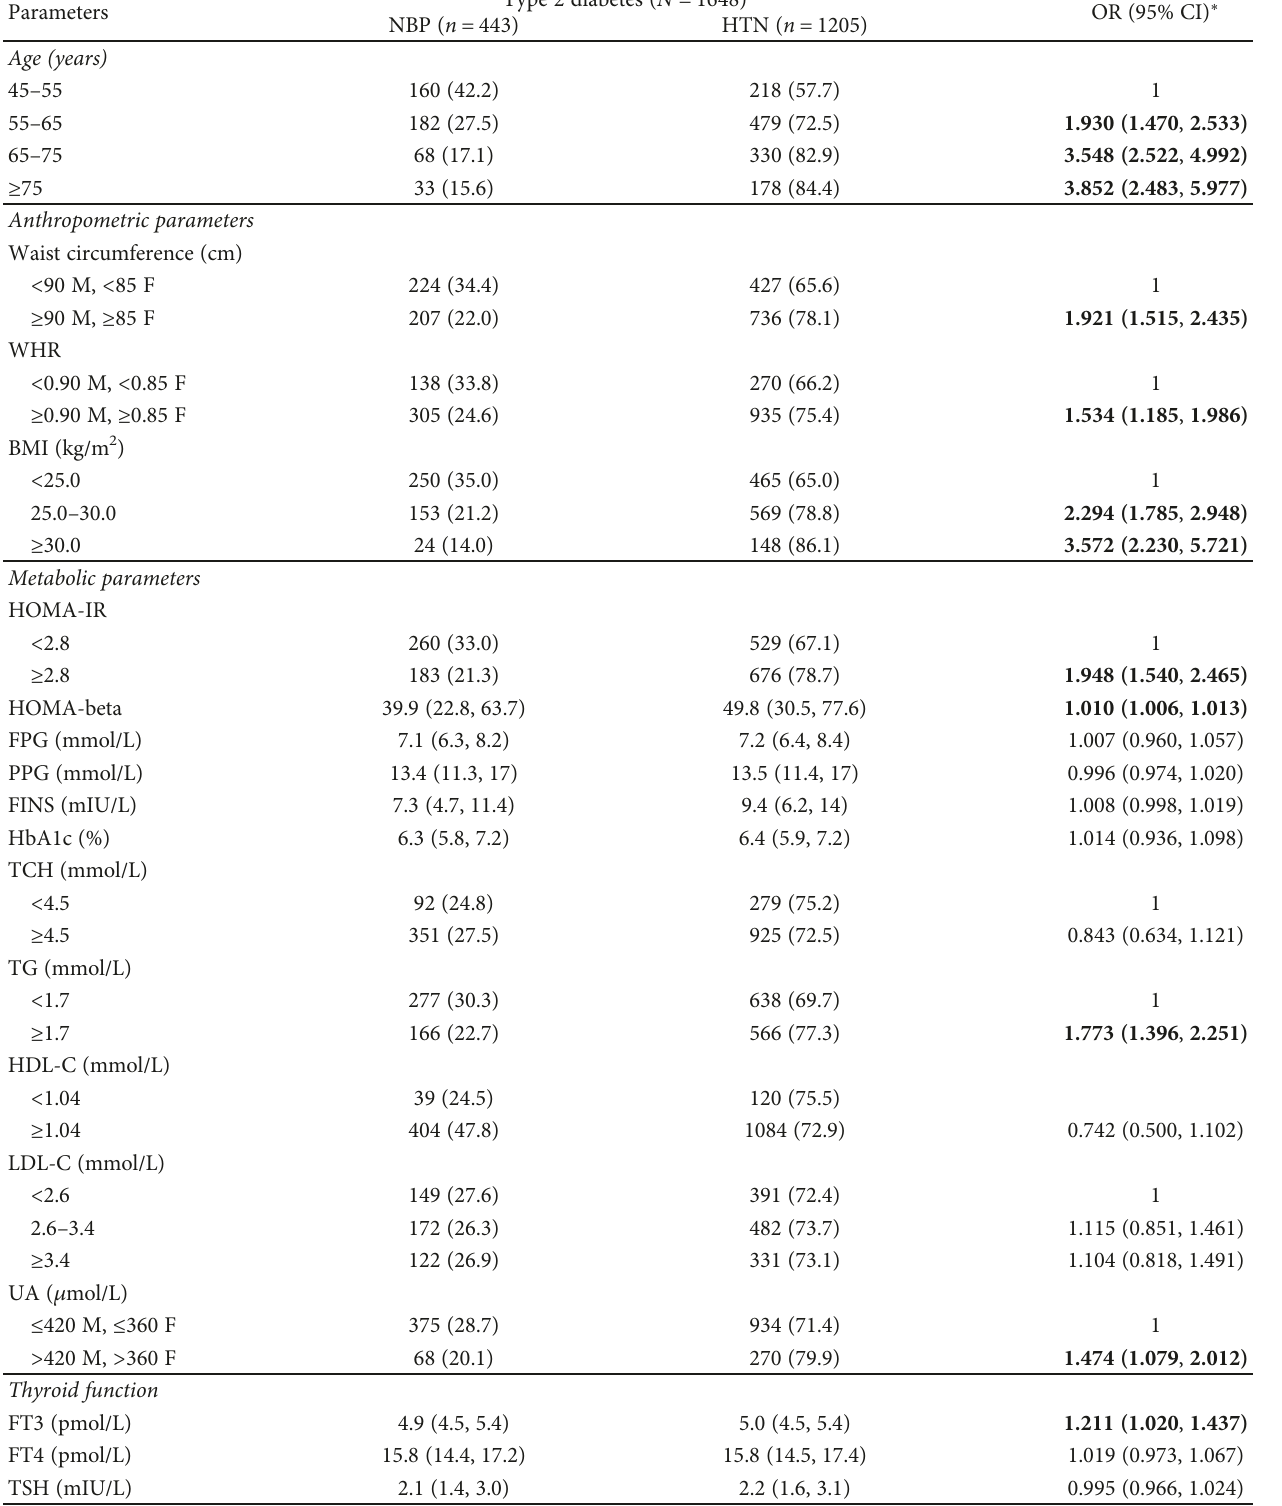
Table 3: Strati fi ed analysis of NAFLD and the associated metabolic risk factors in type 2 diabetes with or without HTN.